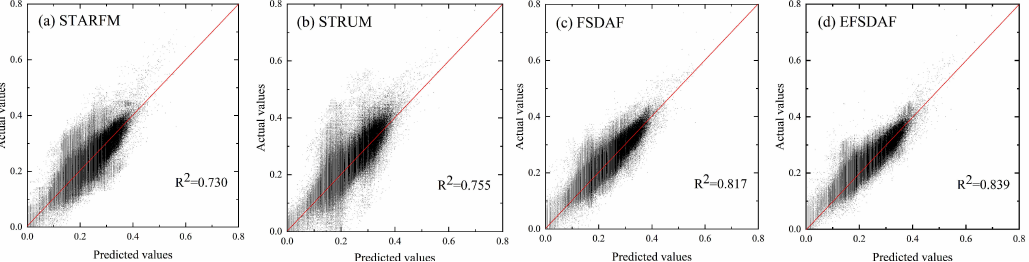
Figure 6. Scatter plots of the true values and predicted values for NIR band in dataset 1. From left to right, ( a – d ) the scatter plots for STARFM, STRUM, FSDAF and EFSDAF,